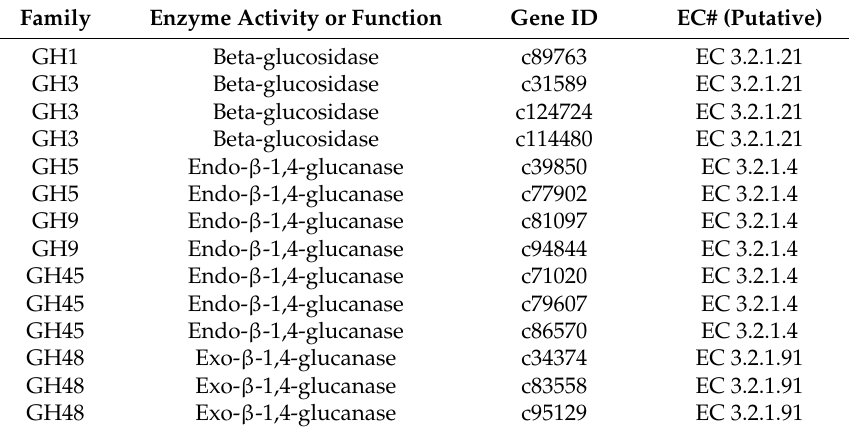
Table A1. Hemicellulase-associated enzyme family in the M. alternatus